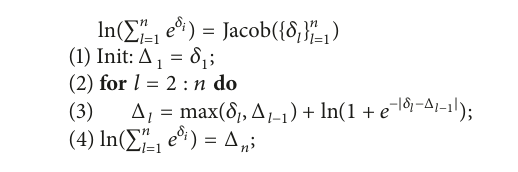
Algorithm 1: Iterative Jacobian algorithm.